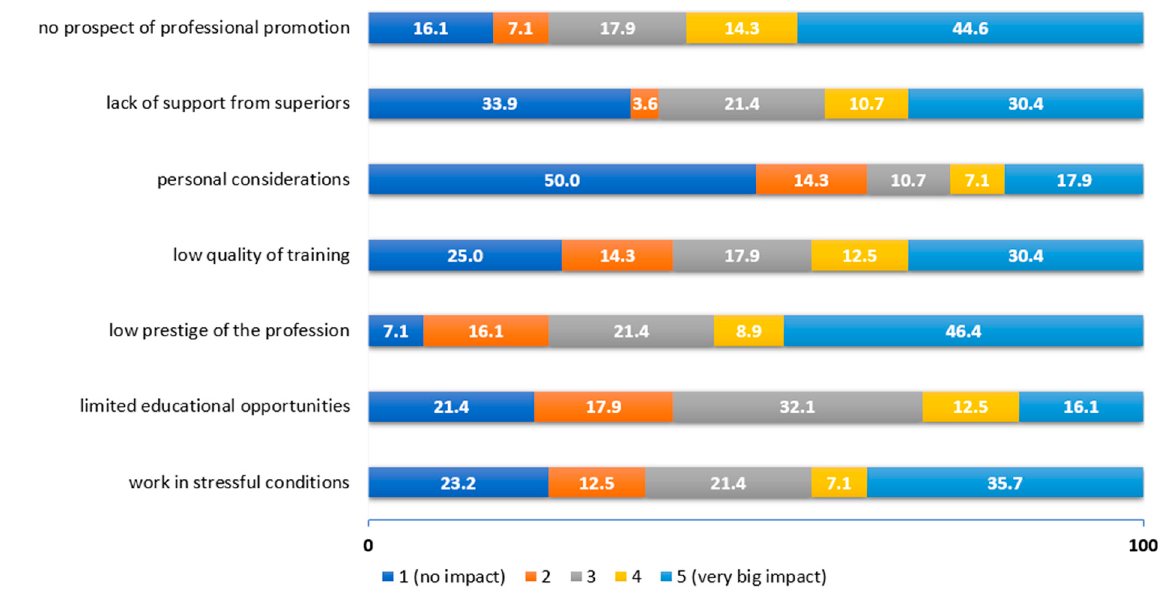
Figure 5. Assessment of the influence of push factors according to practicing